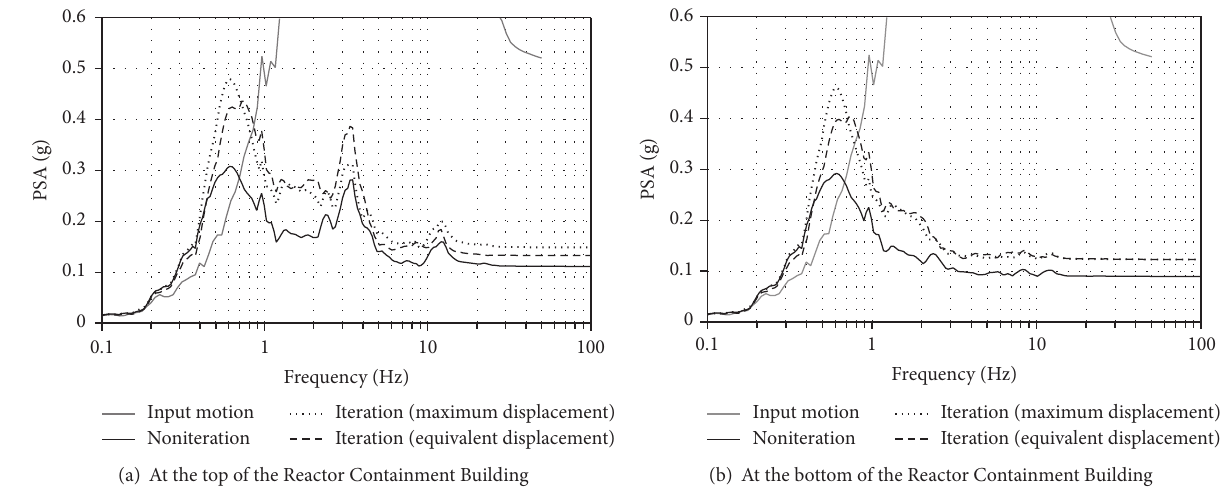
Figure 11: Comparison of the response spectral acceleration for different analysis methods.